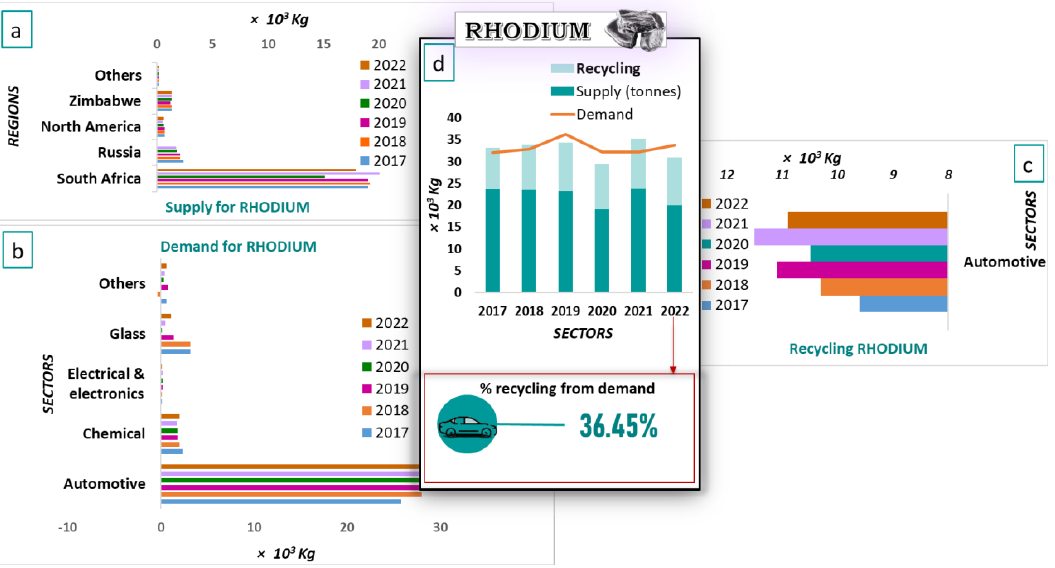
Figure 6 . ( a ) Rhodium supply by region from 2017 – 2022; ( b ) Rhodium demand by sectors from Figure 6. ( a ) Rhodium supply by region from 2017–2022; ( b ) Rhodium demand by sectors from 2017 – 2022; ( c ) Rhodium recycling by sectors from 2017 – 2022; ( d ) Global rhodium recycling, supply 2017–2022; ( c ) Rhodium recycling by sectors from 2017–2022; ( d ) Global rhodium recycling, supply and demand from 2017 – 2022 (according to the data from [49]). and demand from 2017–2022 (according to the data from [49]).